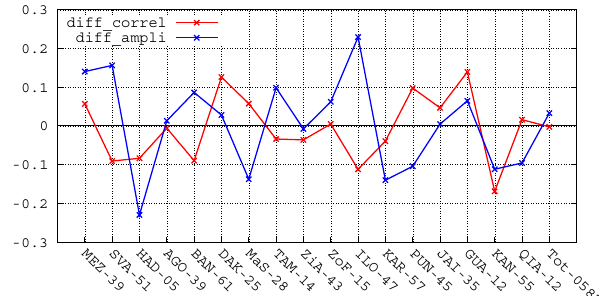
Figure 8. Differences, site by site and total (“Tot”), found between the MITR and “revisited” evaluations (see Sect. 4.3) for the AOD (IASI versus AERONET) and for the sites over land (see Table 3). Differences in correlation are shown in red; differences in amplitude (normalized standard deviation) are shown in blue. Positive (nega- tive) values mean better correlation and an amplitude closer to 1 for MITR